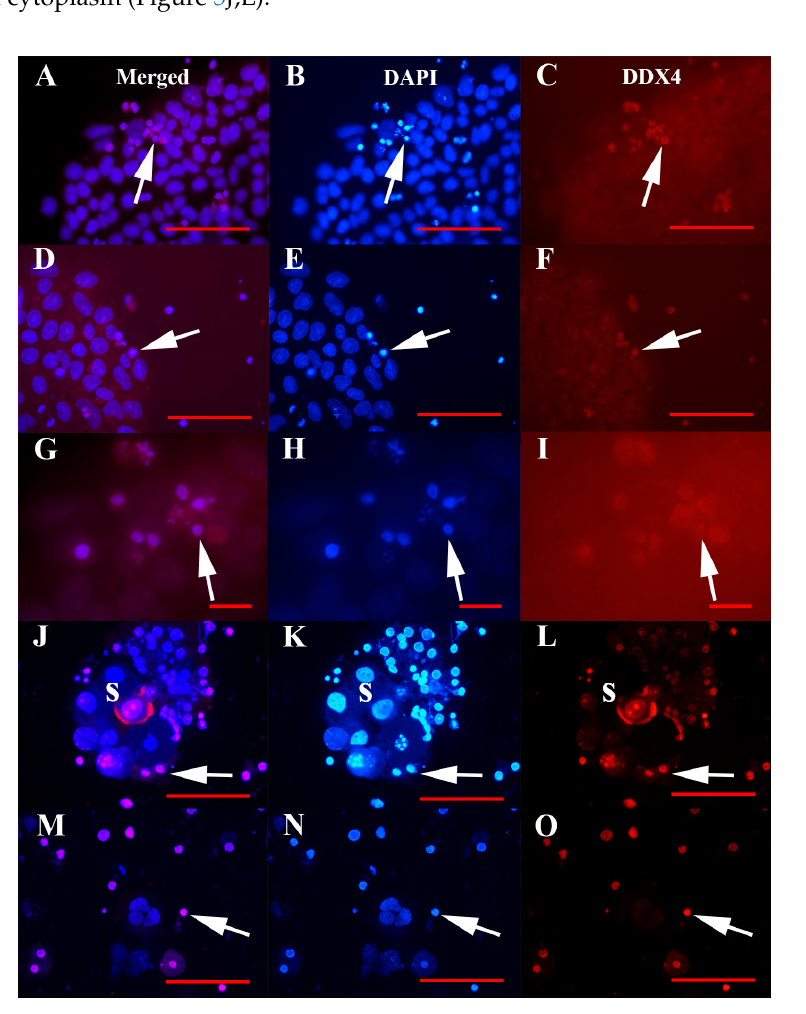
Figure 5. DDX4-positive VSEL-like stem cells with diameters of up to 5 μ m in cell cultures, as revealed using immunofluorescence. ( A – I ) Human embryonic stem cells (hESCs), and ( J – O ) recurrent ovarian cancer ascites cell culture with spheroids. Fluorescence microscope. Legend: s— spheroid; red fluorescence—DDX4-positivity; blue fluorescence—genetic material after DAPI staining. Red bar: 10 μ m for G–I; 50 μ m for A–F, J–O.